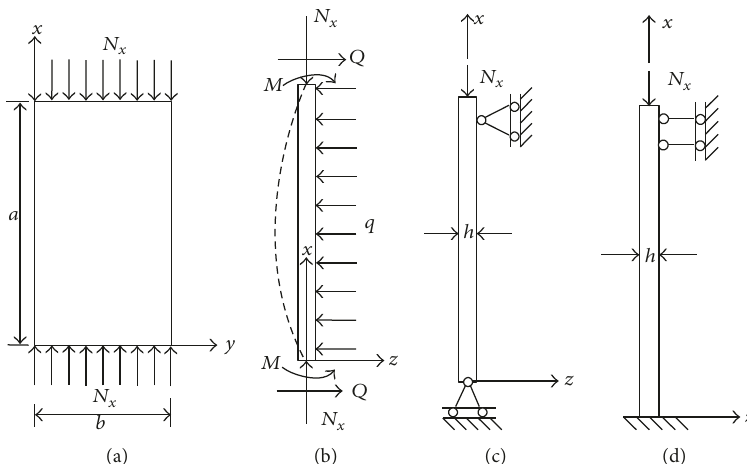
Figure 10: The mechanical model of the stability analysis of layer-crack plate structure: (a) the front view of the mechanics model; (b) the side view of the mechanics model; (c) two-end clamped; (d) two-end simply